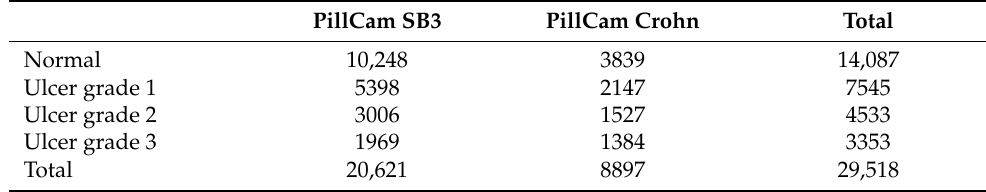
Table 1. Small bowel CE images.